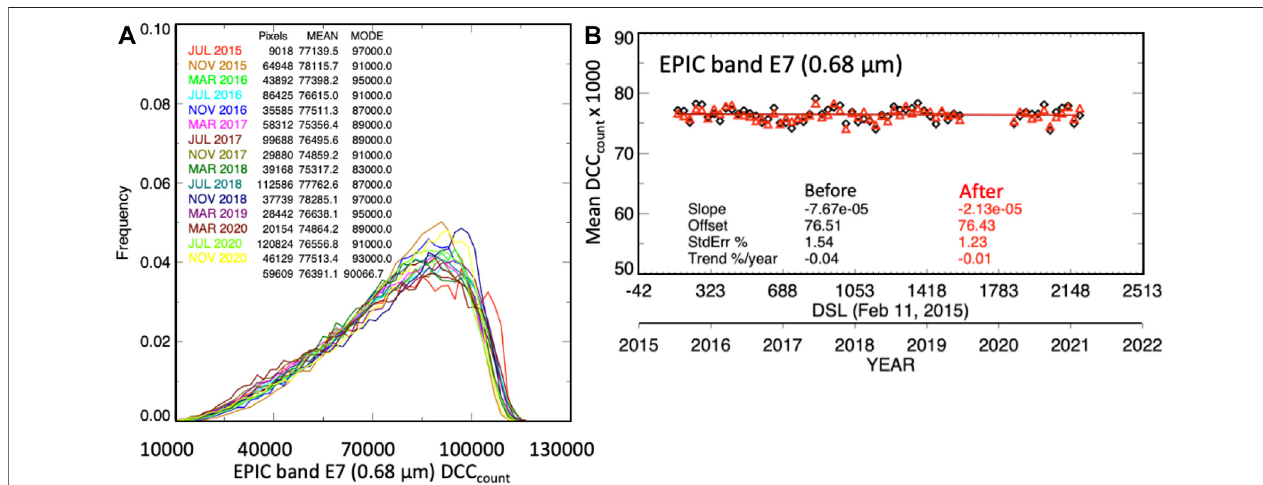
FIGURE 3 | (A) The July, November, and March over the EPIC record monthly probability density functions (PDF) of the E-7 DCC count ( Eq. 2 ). The number of monthlyDCC identi fi ed grid cells ( Pixels ),mean DCC count ( MEAN ),and PDF mode DCC count ( MODE ) statistics are located in theupper left corner. The monthly PDF lines are color coordinated with the month and year column of the statistics. (B) The DCC E-7 monthly mean DCC count and associated linear trend line before (black open circlesand line)and after (red open triangles and line)deseasonalization. The linearregressionslope(DCC count /day),offset, mean DCC count ,standard error( STDerr % ), and linear trend are located at the bottom of the